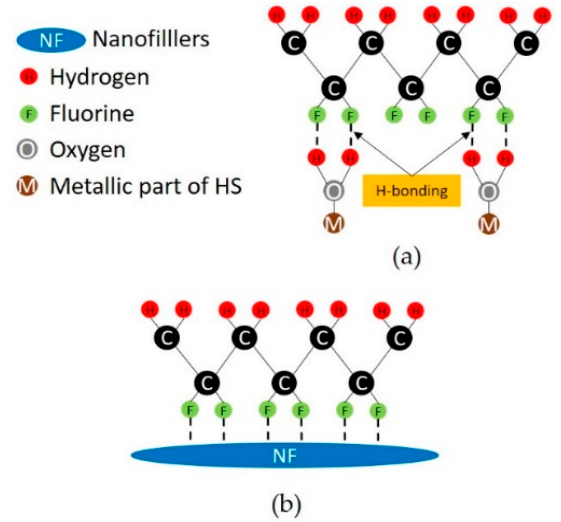
Figure 11. Schematic representation of ( a ) the formation of H-bonding with the metallic part of HS and the CF 2 group of PVDF, and ( b ) the electrostatic interaction between the nanofillers (either GNP or ZnO NRs) and the CF 2 group of PVDF.